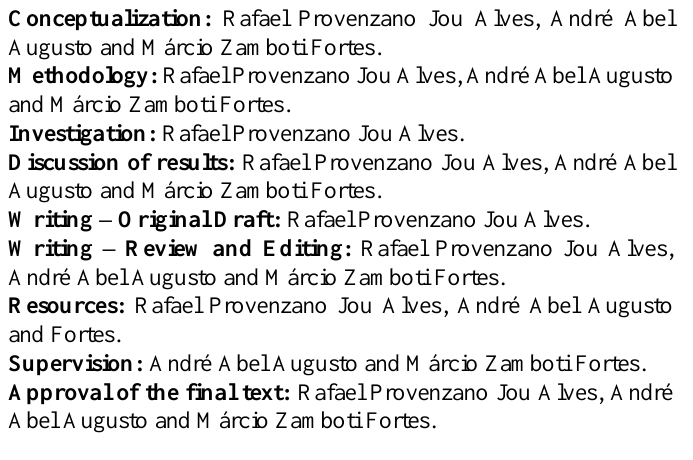
Table 6: Comparison of Voltage THD. Voltage Output UPS A in % PRODIST